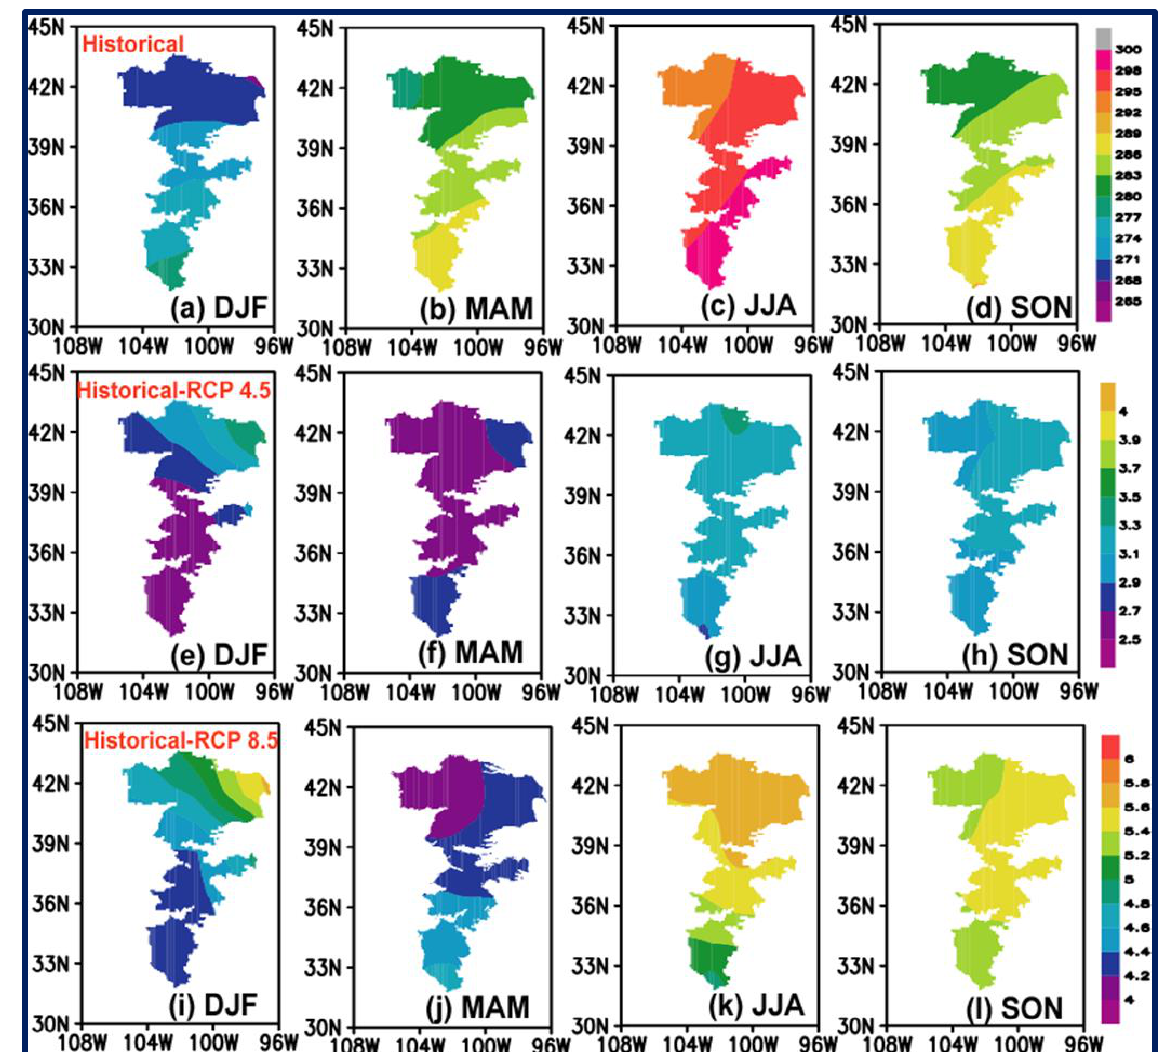
Figure 5. Seasonal ensemble mean temperature in the study region. Historical simulations ( a – d ) and the difference between future and historical for RCP4.5 (2006 – 2099 ( e – h )) and RCP8.5 (2006 – 2099 ( i – l )), respectively, for the different seasons (DJF — winter; MAM — spring; JJA — summer; SON — fall). Thirty-five general circulation models (GCMs) were used in estimating the ensemble mean.